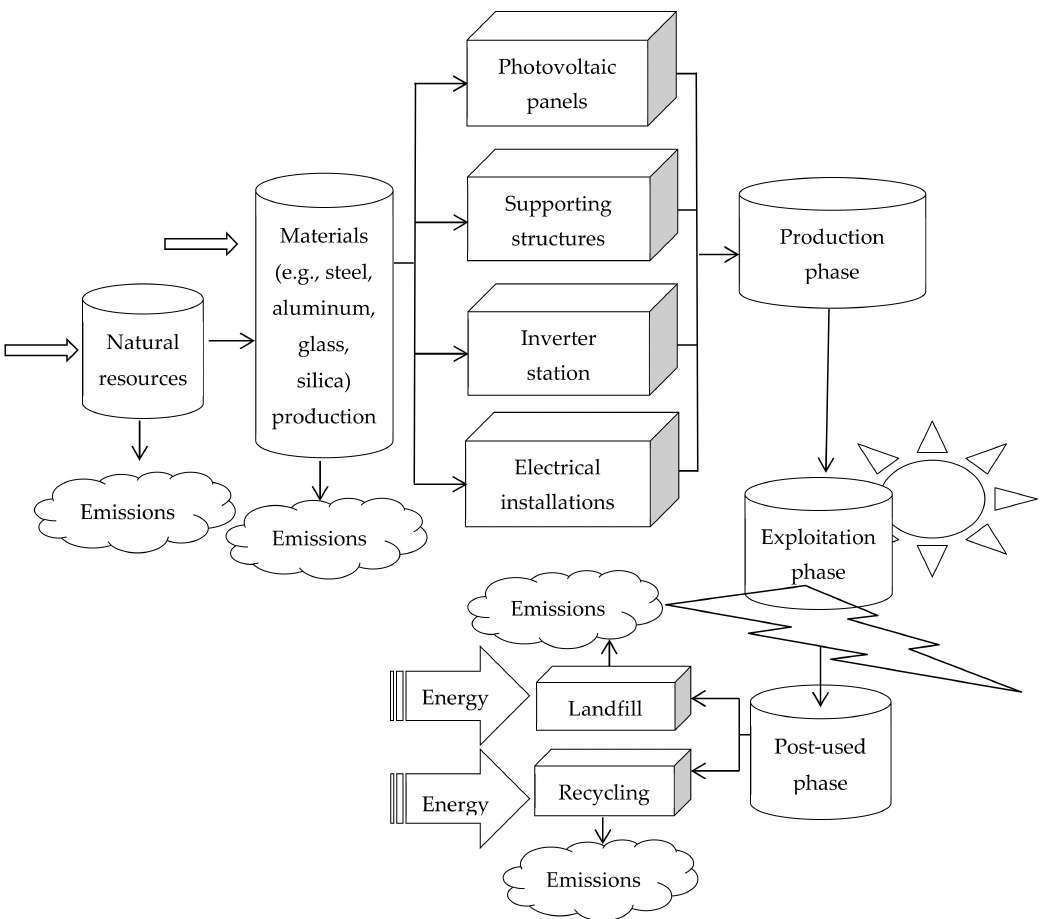
Figure 2. The material life cycle of photovoltaic power